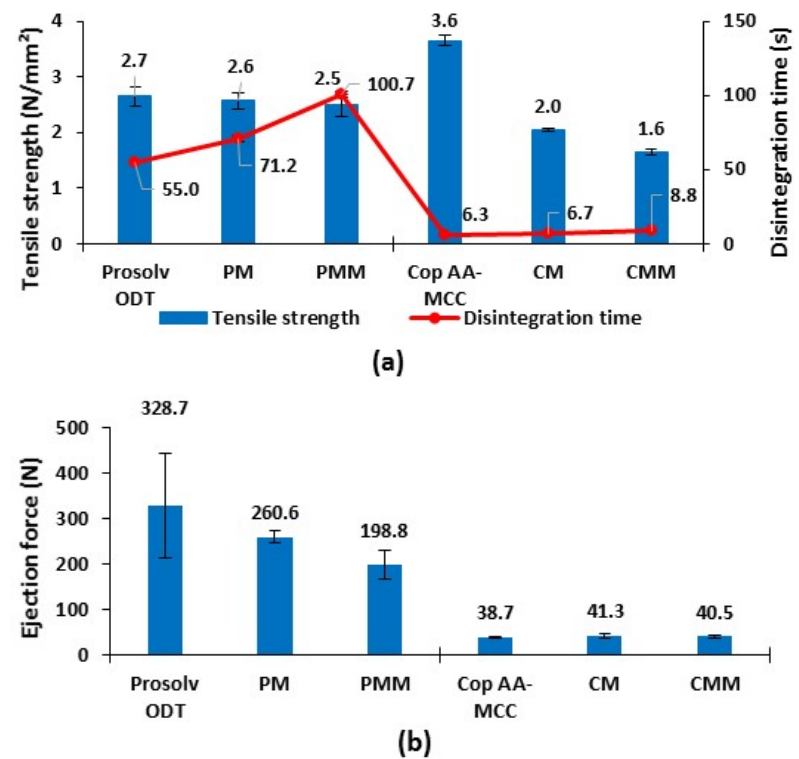
Figure 9. ( a ) Tensile strength, disintegration time, and ( b ) ejection force of tablets obtained from Cop AA-MCC, Prosolv ODT, CM: Cop AA-MCC/Melatonin, PM: Prosolv ODT/Melatonin, CMM: CM/MgSt, and PMM: PM/MgSt, compressed at 5 kN.